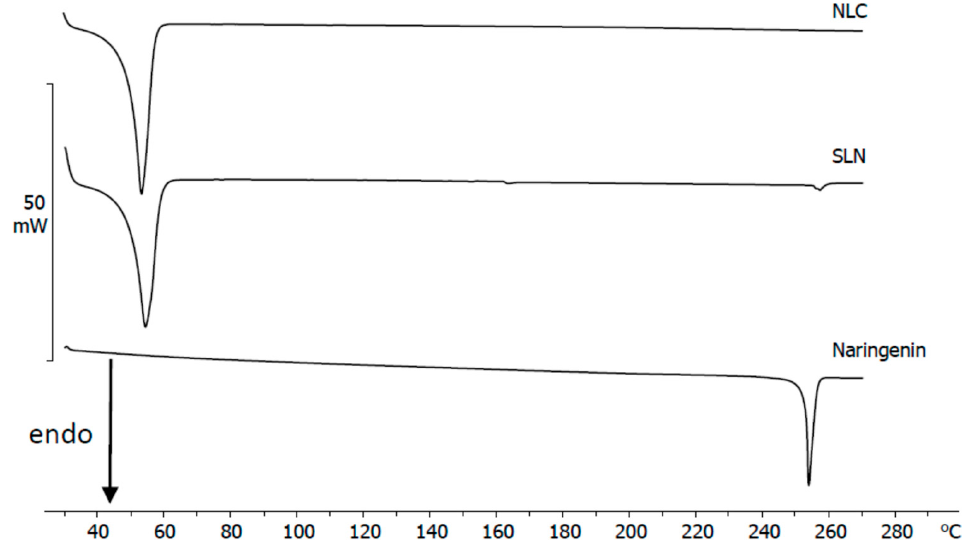
Figure 4. Calorimetric curves, in heating mode, of Naringenin, Naringenin-loaded SLN, and Naringenin-loaded NLC after speed-vacuum drying.